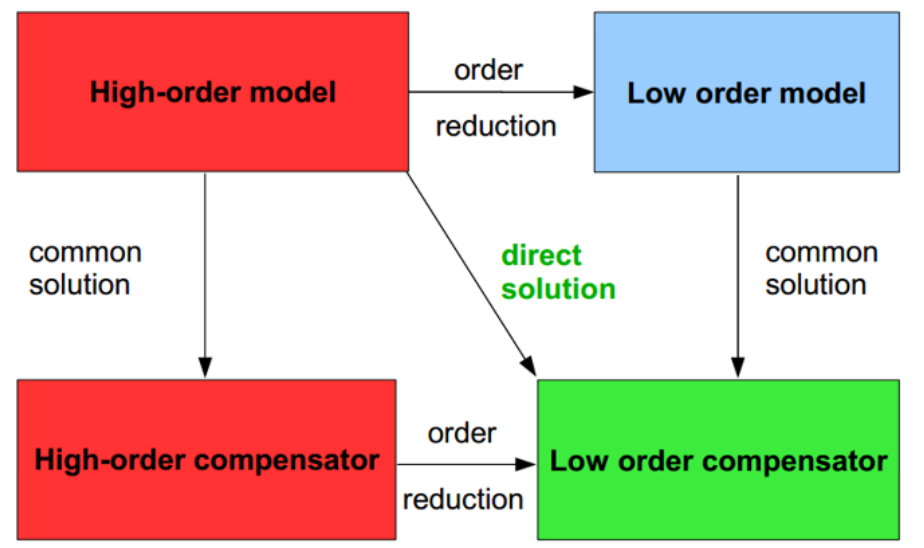
Figure 6. Model reduction workflow allowing implementation of motion systems using industrial- grade hardware and fixed-structure low-order control